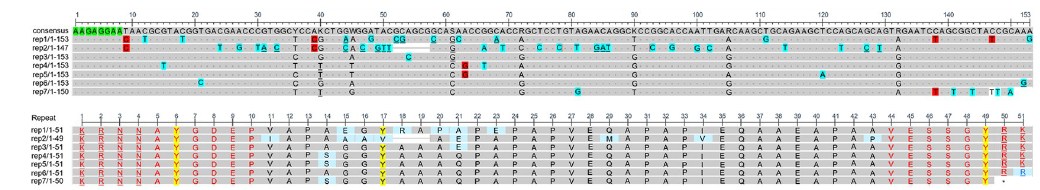
Fig 2. Characteristics of the aligned nucleotide and deduced amino acid repeats of the gene Asu-epic-1 . A gap is introduced in repeat 2 for an optimal alignment. The seven aligned repeats (without the signal peptide sequence) vary in length from 147 to 153 nucleotides and start with a conserved motif of eight nucleotides (green). The seven repeats are individually colored. These colors are reused in Fig 3. Nucleotide variations between repeats are highlighted in blue, red, or black letters. Blue highlighted nucleotides are specific for a given repeat. Nucleotides highlighted in red are present in two repeats. Black letters of nucleotides show at a given position variations in more than two repeats. Underlined nucleotides lead to changes in the amino acid residues. In the amino acid repeats, the regions at the N- and C-terminal sides are conserved (red letters). Underlined red amino acids represent hydrophilic motifs. Each of the conserved region contains one tyrosine residue (highlighted in yellow). A third tyrosine (yellow) is present in between, except in repeat 2. Amino acid variations between the repeats are highlighted in blue. Repeat 6 ends with an arginine (blue) instead of the usual lysine.